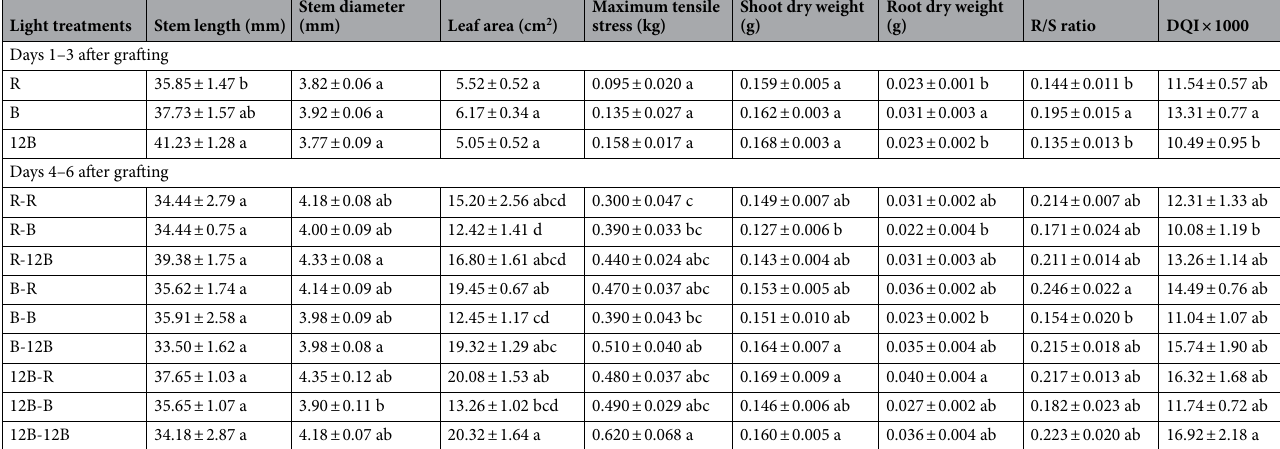
Table 3. Morphological parameters, biomass production, and quality indices of grafted watermelon seedlings after three or six days in the healing chamber under three or nine light treatments, respectively. R/S dry root- to-shoot ratio; DQI Dickson quality index. Mean values (± SE) within a column followed by different letters are significantly different (a < 0.05). Mean values derived from n = 10